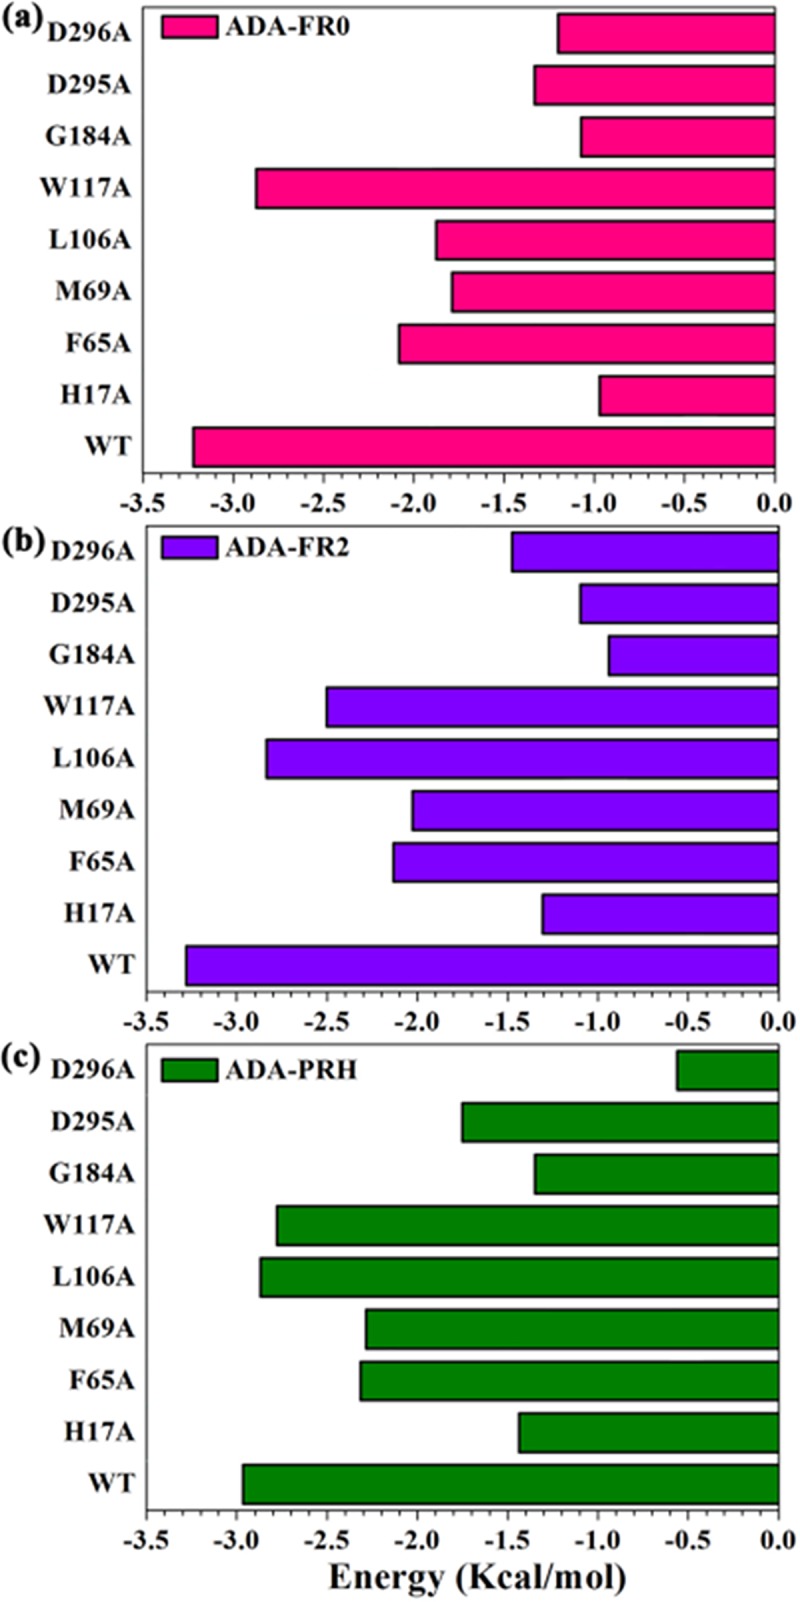
Computational alanine scanning of the binding site residues in open and closed inhibitor complexes.Analysis was performed using FoldX approach on the conformational ensembles obtained from the 200 ns MD simulations. Binding free energies and alanine scanning of the binding site residues are shown for ADA-FR0 α-ZOL (a), ADA-FR2 (b), and ADA-PRH (c). Energetic binding hotspots correspond to residues whose alanine scanning results indicate a significant decrease in binding free energy.